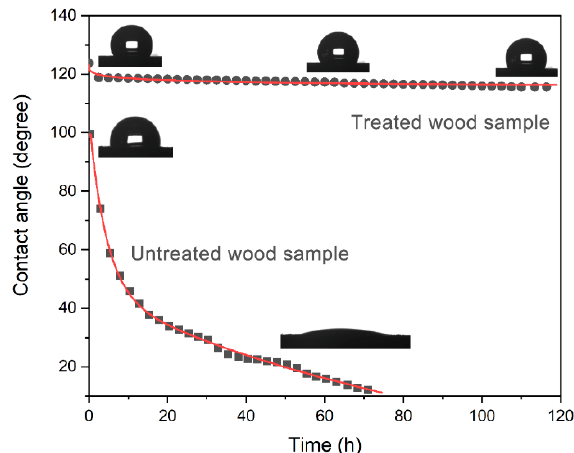
Figure 8. Dynamic wettability of both untreated and treated wood samples. The treated wood sample exhibited higher initial contact angle than untreated wood, and the succeeding measurements maintained above 110°.